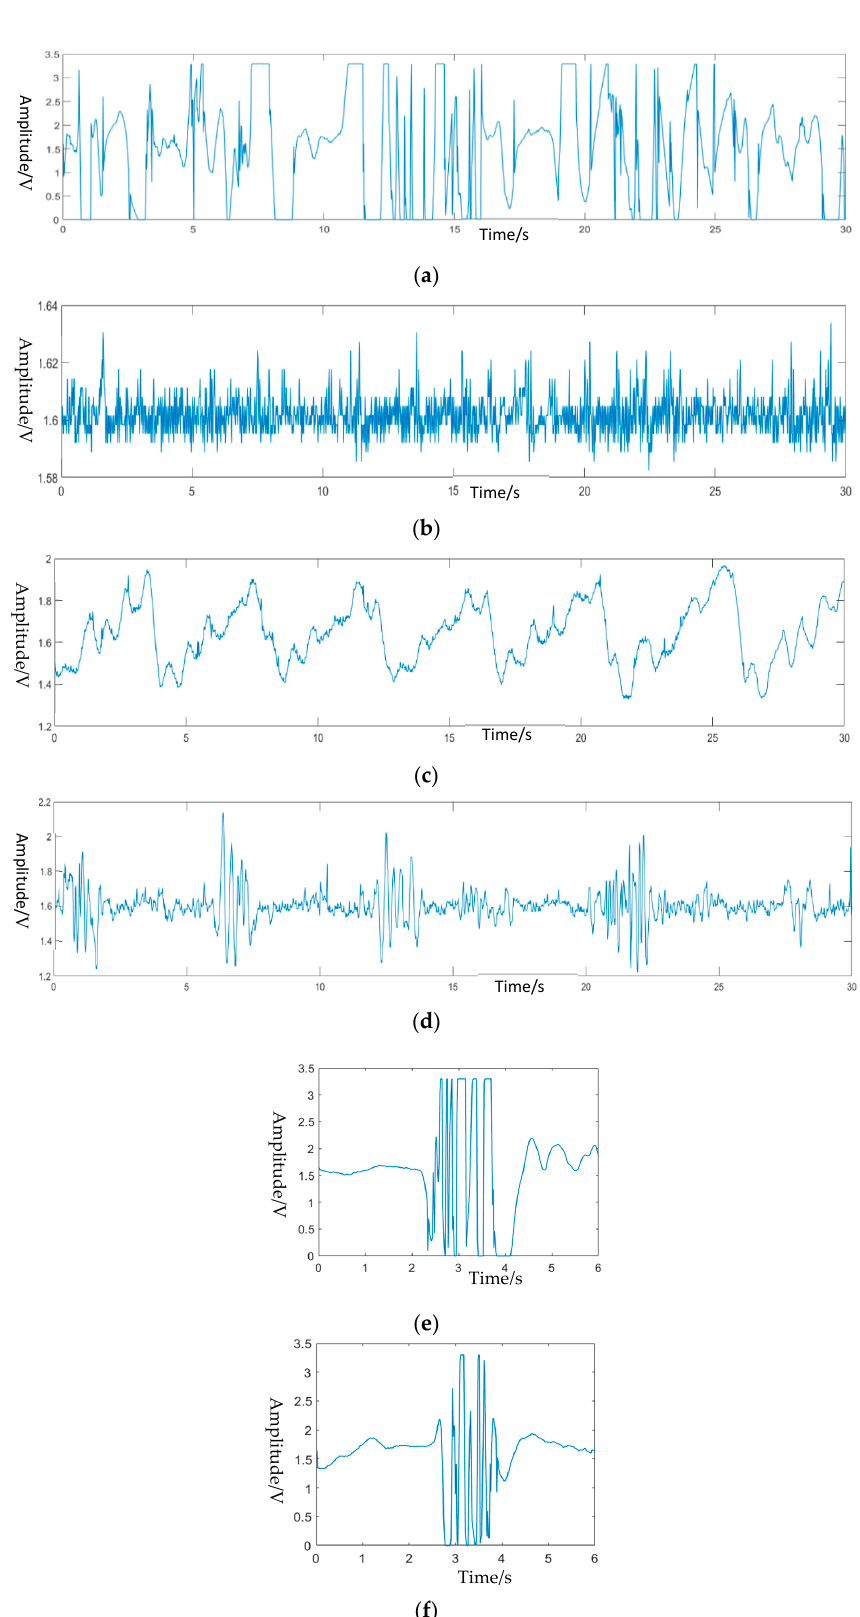
Figure 5. Signals corresponding to di ff erent movement states. ( a ) Limb moving. ( b ) Unmanned environment. ( c ) Static measurement. ( d ) A second person entering. ( e ) Sitting down. ( f ) Standing